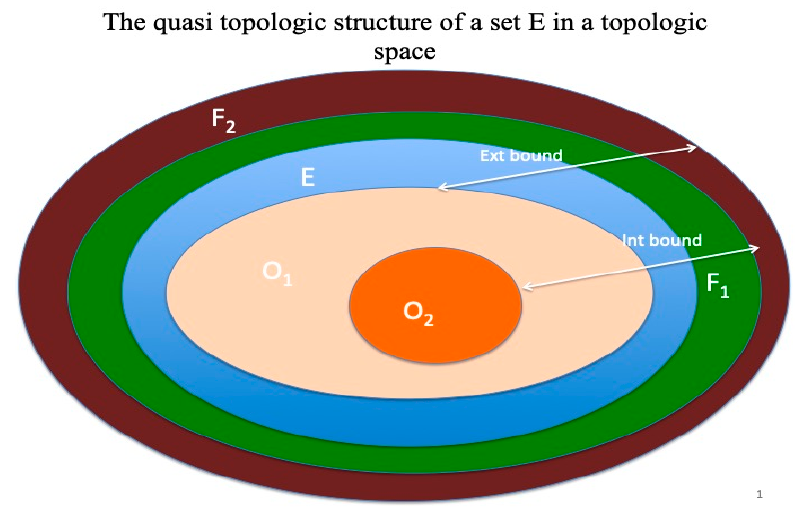
Figure 5. The quasi topology structure of a set E in a topological space.